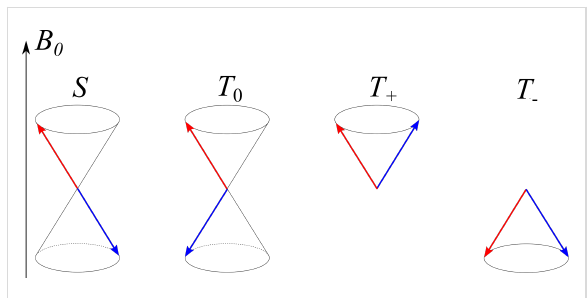
Figure 2: Vector model of the spin states of a radical pair. Here the red and blue arrows show the spin vectors of the two radicals; at high B 0 field, each spin precesses on a cone about the z -axis, here z || B 0 . The singlet state is the state with anti-parallel spins. In the T + and T − state there is positive and negative net polarization of the two spins on the direction of the B 0 field axis, respectively. In the T 0 state there is no net z -magnetization, but the total spin is non-zero.